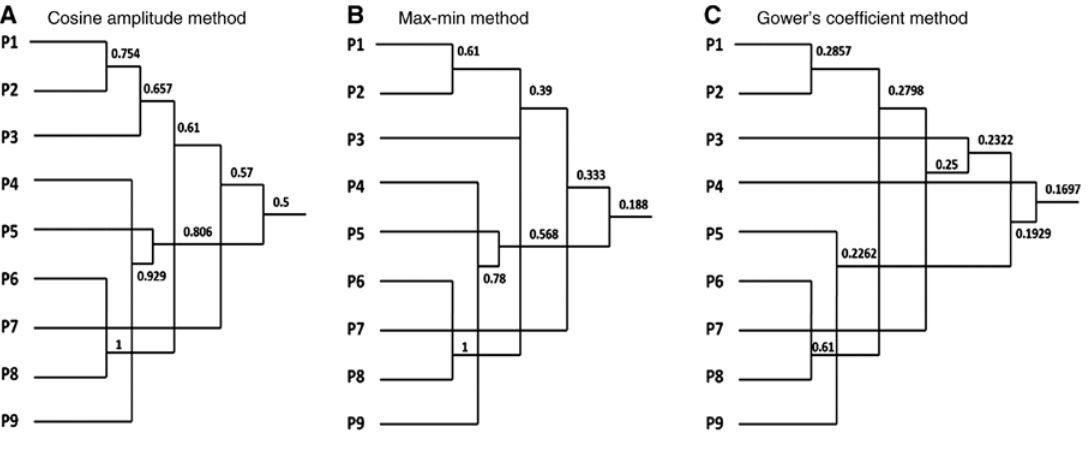
Figure 1: Classification of Patients. Classification diagram using the cosine amplitude, max-min, and Gower’s coefficient methods (case study: nine patients, nine symptoms).